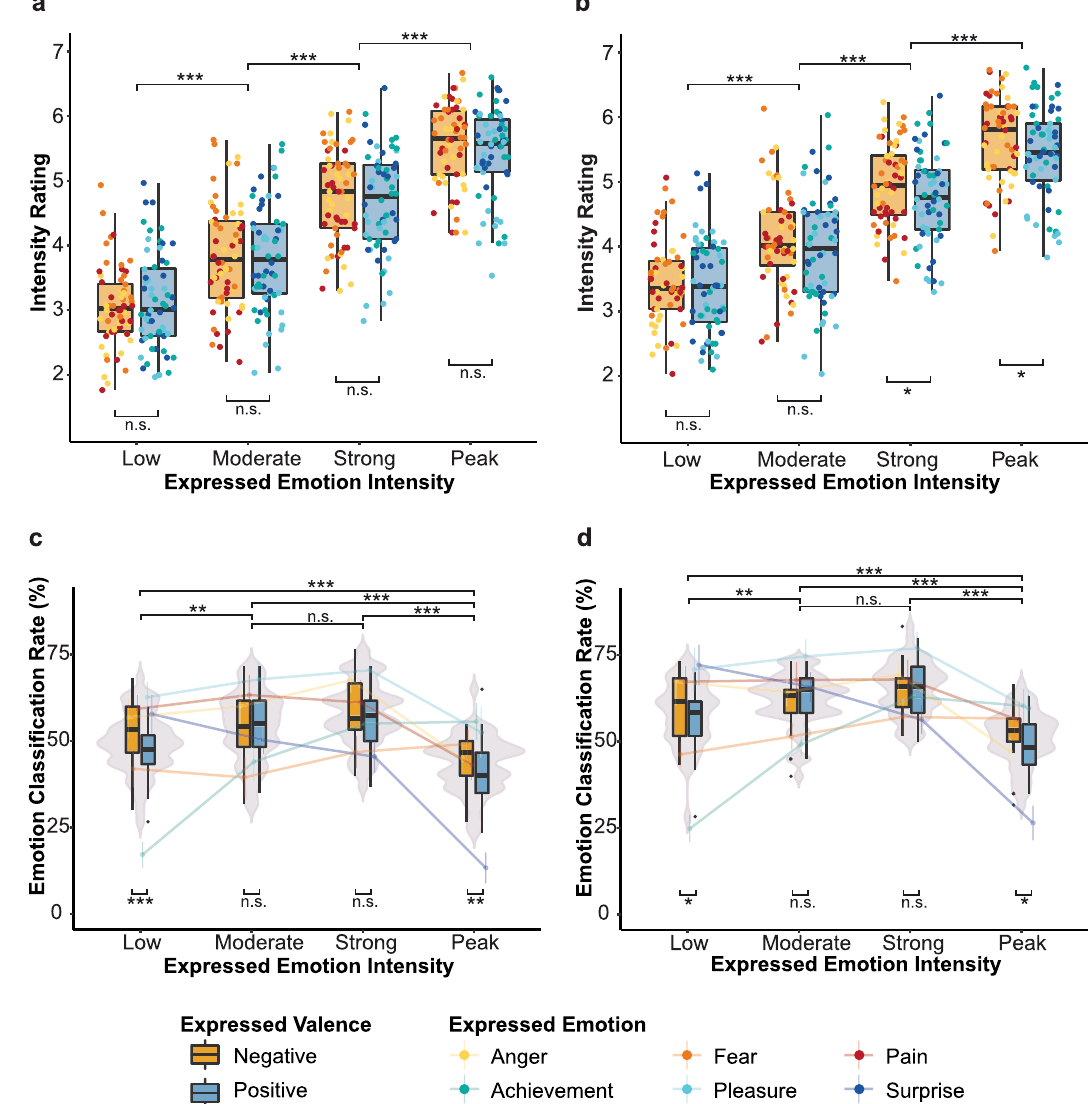
Figure 3. Paradoxical role of intensity. ( a , b ) Show positive relation of expressed and perceived intensity in Experiment 1(a) and 2 (b). Stimuli (dots) are grouped by expressed valence, emotion and intensity. ( c , d ) Show emotion classification accuracy as a function of valence, emotion, and intensity in Experiment 1(c) and 2(d). Violin plots represent the effect of intensity on correct emotion classification, box plots represent the interaction of valence and intensity, and lines represent the interaction of emotion and intensity on correct emotion classification. Error bars indicate 95% confidence intervals. n.s. = non-significant. * p < 0.05. ** p < 0.01. *** p < 0.001. Figure created with R version 4.0.3 35